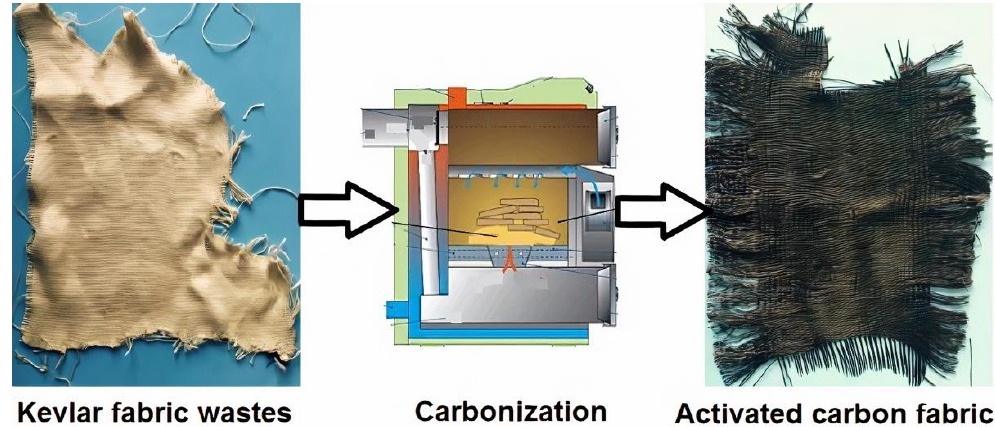
Figure 2. Representation of activated carbon fabric preparation from Kevlar fabric waste.